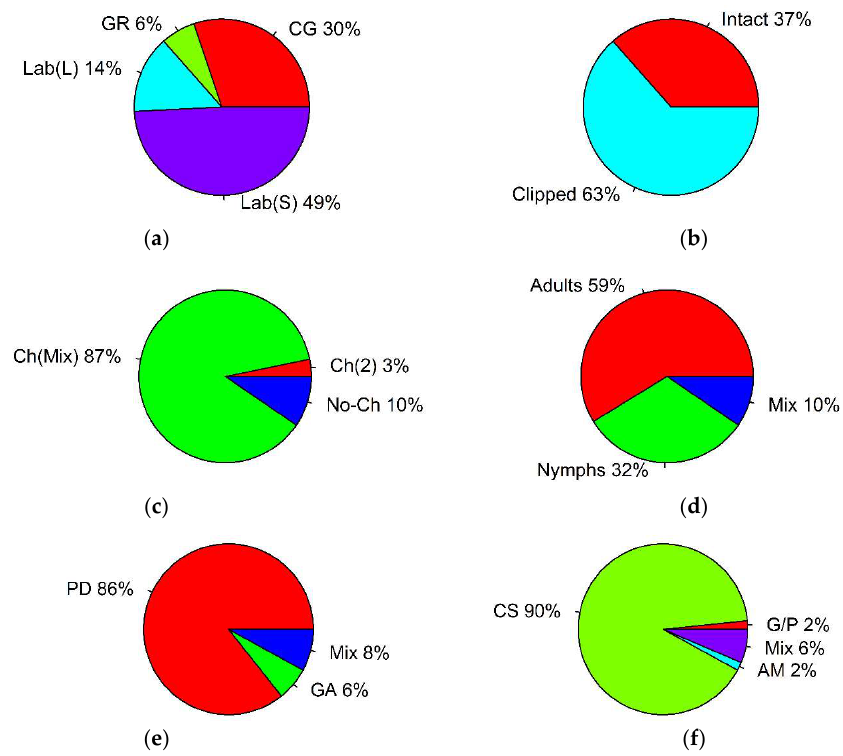
Figure 1. Percentage of studies that reported different experimental set-ups used to estimate grasshopper feeding preferences: (a) Types of the experimental environment used (CG: Common garden; GR: Greenhouse; Lab(S): Laboratory, clipped stems; Lab(L): Laboratory, clipped leaves); (b) type of plant material; (c) type of preference trial (Ch(Mix): Choice with a plant mixture; Ch(2): Choice with two plants; No-Ch: No-choice); (d) grasshopper life stage used; (e) general preference measurements (PD: Plant damage; GA: Grasshopper activity); and (f) grasshopper activity measurements (CS: Consumption; AM: Assimilation; G/P: Growth and performance).